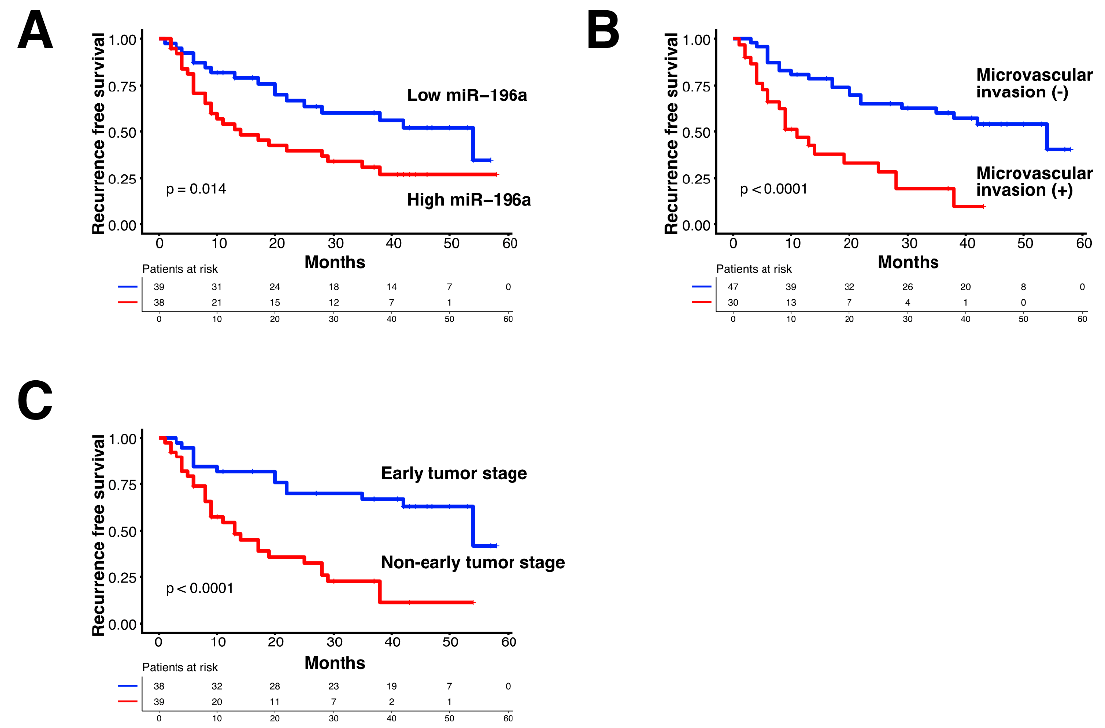
Figure 1. Factors associated with recurrence-free survivals in hepatocellular carcinoma (HCC) patients who underwent tumor resection. ( A ) A Kaplan–Meier method compares cumulative recurrence-free survivals between HCC patients with high or low miR-196a expression. ( B ) Comparison of recurrence-free survivals between HCC patients with or without microvascular invasion. ( C ) Comparison of recurrence-free survivals between HCC patients with early or non-early tumor stages.